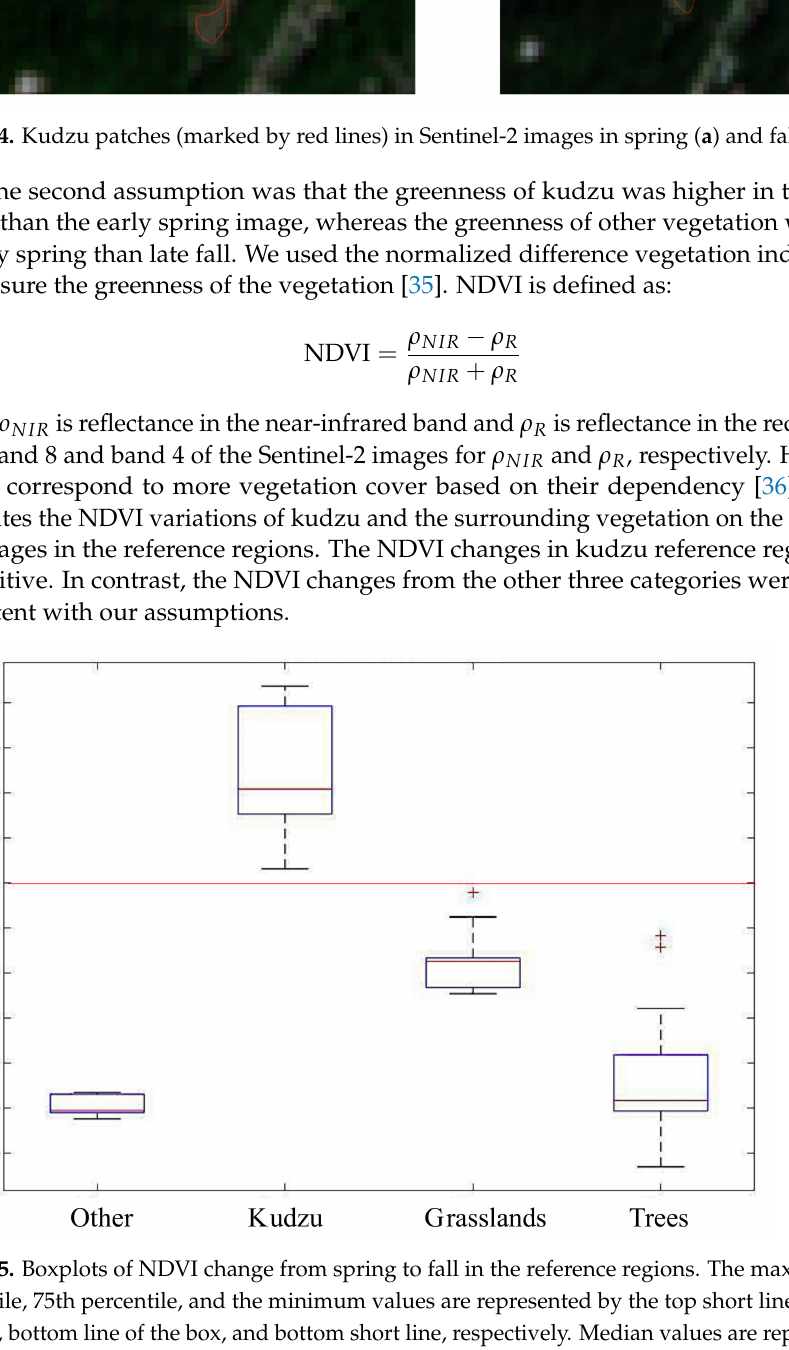
Figure 5. Boxplots of NDVI change from spring to fall in the reference regions. The maximum, 25th percentile, 75th percentile, and the minimum values are represented by the top short line, top line of the box, bottom line of the box, and bottom short line, respectively. Median values are represented by the red line inside the box. Outliers are represented by crosses. The horizontal red line at 0 means no changes in NDVI